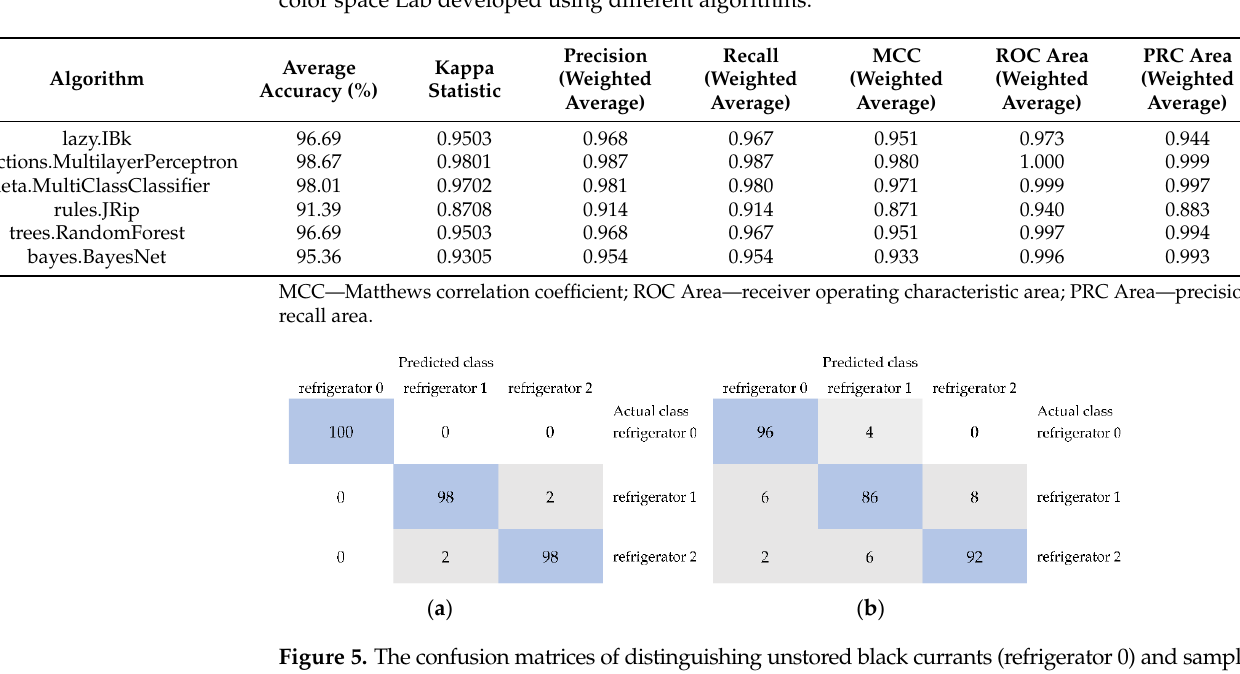
Table 4. The performance metrics of distinguishing unstored black currants and black currants stored in the refrigerator (for one week and two weeks) based on models including selected textures from color space Lab developed using different algorithms.